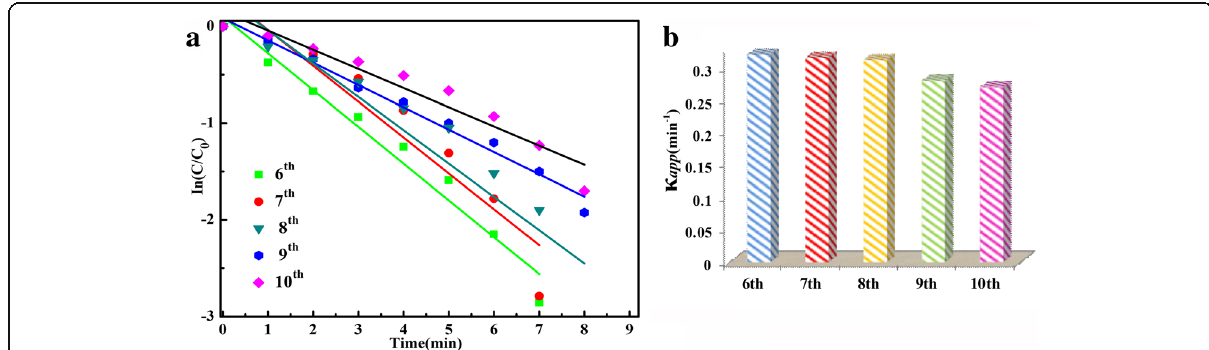
Fig. 8 a , b Plot of ln( C t / C 0 ) versus reaction time of the sixth to tenth cycles for the 36 h